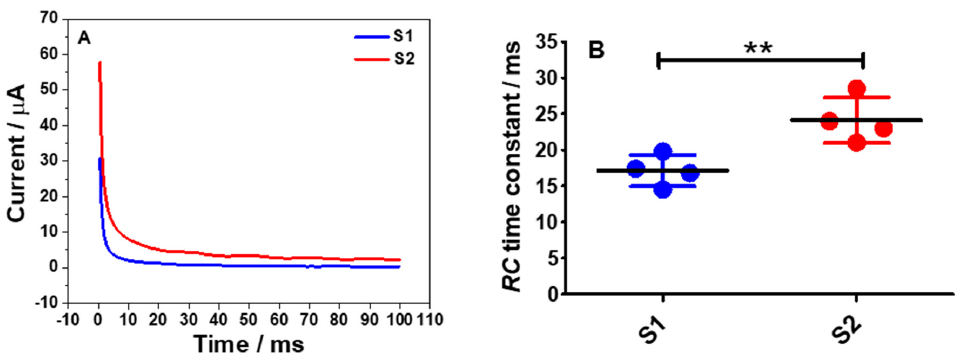
Figure 7. ( A ) Chronoamperograms of S1(blue) and S2(red) electrodes in a degassed 0.1 M PB buffer solution of pH 7 by stepping the potentials from − 0.9 to 0 vs. SCE and it was held at the latter potential for 100 ms. ( B ) Comparison of the RC time constants calculated from the plots of ln i vs. t . Statistical analysis was performed using an unpaired student t -test. Data shown as mean ± S.D., n = 4 and ** denotes p < 0.01.